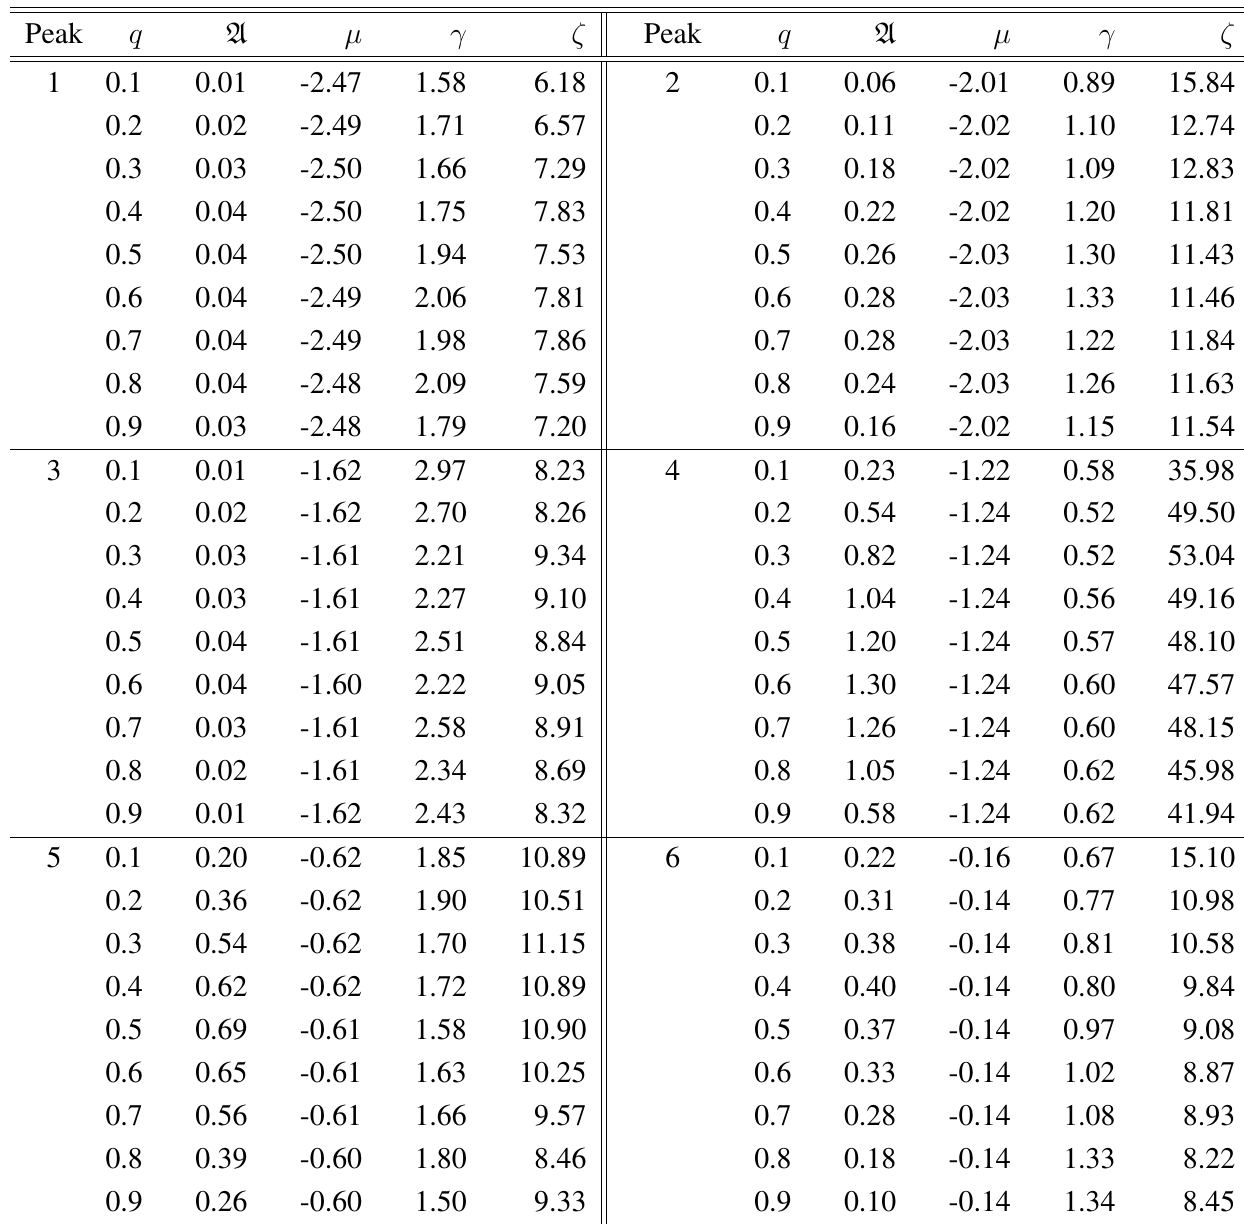
Table 1 . Fit parameters of the L´evy distribution, Equation 13, for the six peaks estimated by the numerical